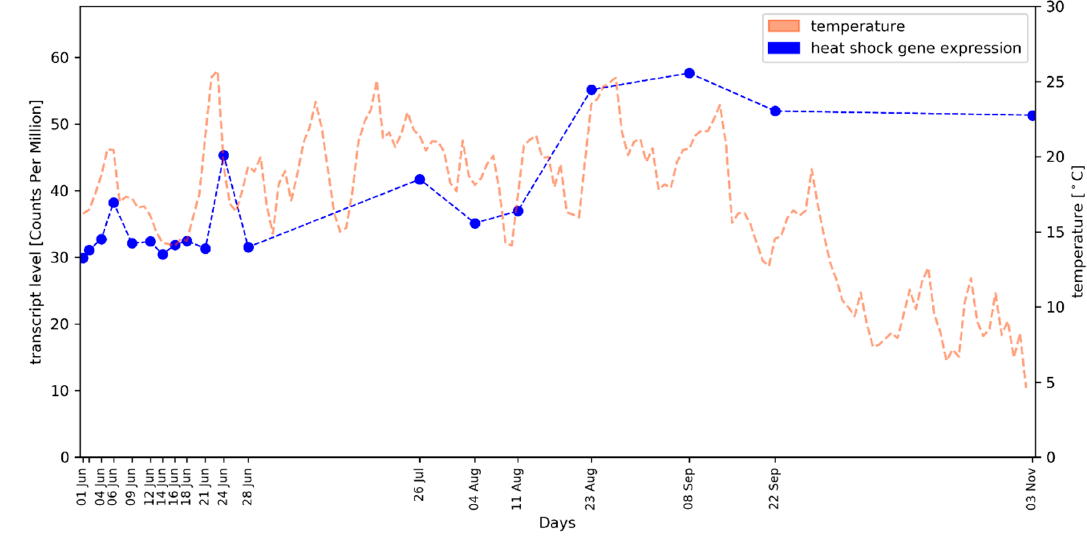
Figure 3. Correlation of averaged heat-shock protein (HSP) gene expression values (median, blue dots/blue dotted line) in developing grapevine buds and environmental air temperature (orange dashed line); the course of the daily average temperature values is shown.